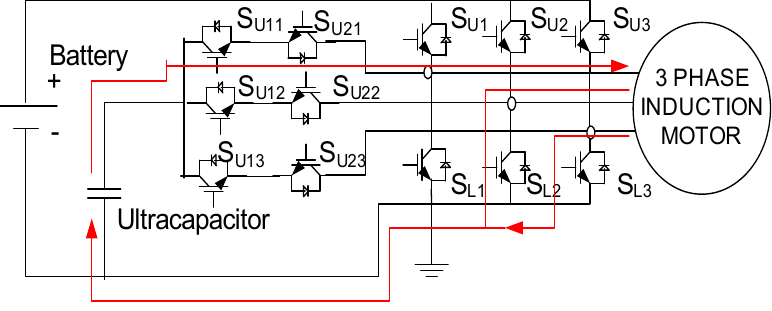
Figure 26. Operation of circuit under mode-3.